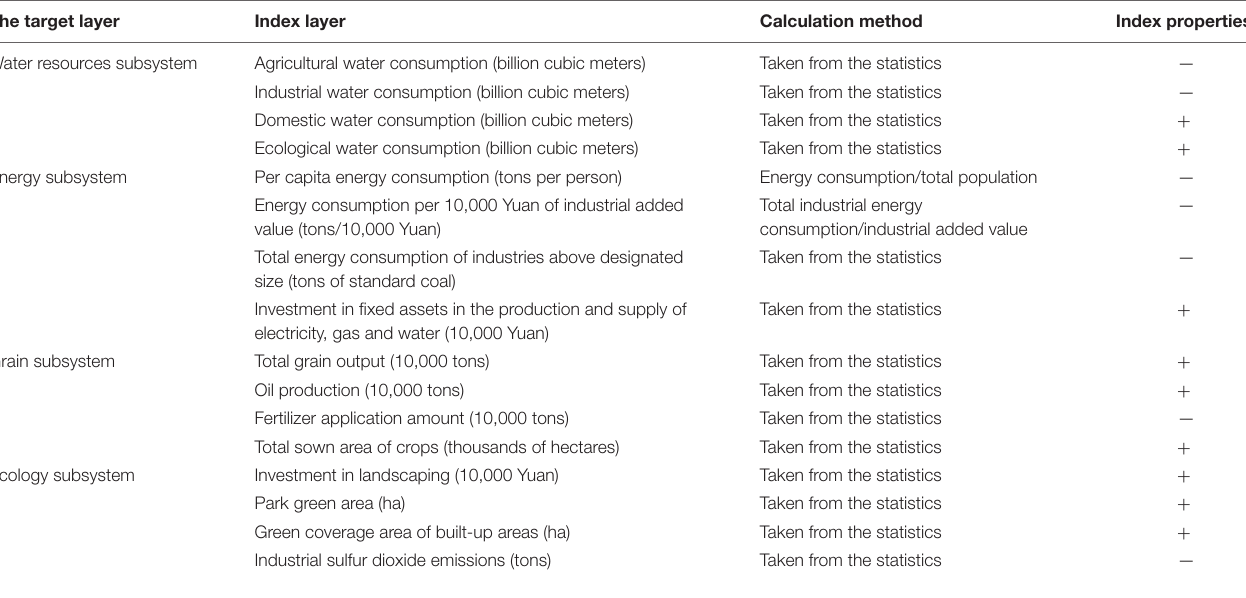
TABLE 1 | W-E-F-E nexus evaluation index